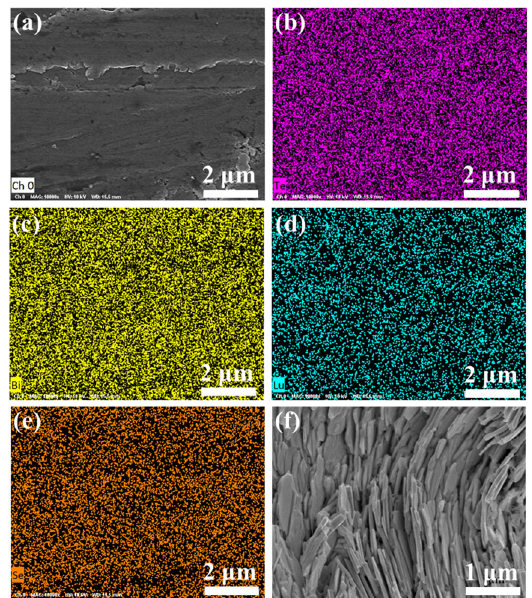
Fig. 3 EDS element mapping of the bulk Lu 0.1 Bi 1.9 Te 2.7 Se 0.3 sample: (a) scanning area; (b) Te; (c) Bi; (d) Lu; (e) Se. (f) SEM image of the fractured surface of bulk Lu 0.1 Bi 1.9 Te 2.7 Se 0.3